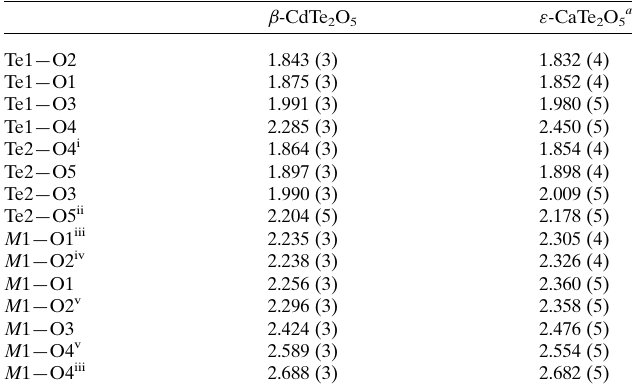
Table 1 Comparison of Te—O and M —O ( M = Cd, Ca) bond lengths (A˚ ) in the isotypic (cid:2) -CdTe 2 O 5 and " -CaTe 2 O 5 structures.